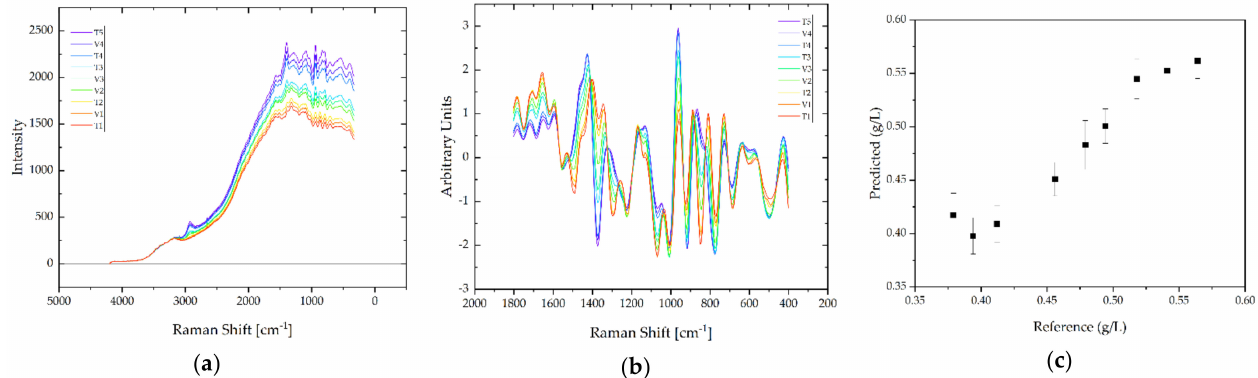
Figure 21. Raman raw ( a ) and processed spectra ( b ) as well as titer prediction vs. reference ( c ) after alkaline lysis and clarification.